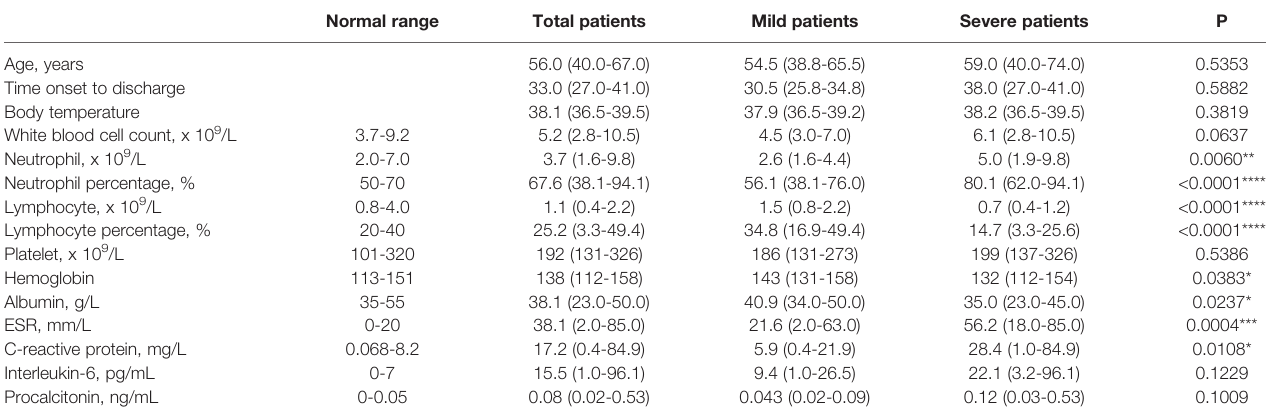
TABLE 1 | Laboratory fi ndings of patients with COVID-19. Normal range Total patients Mild patients Severe